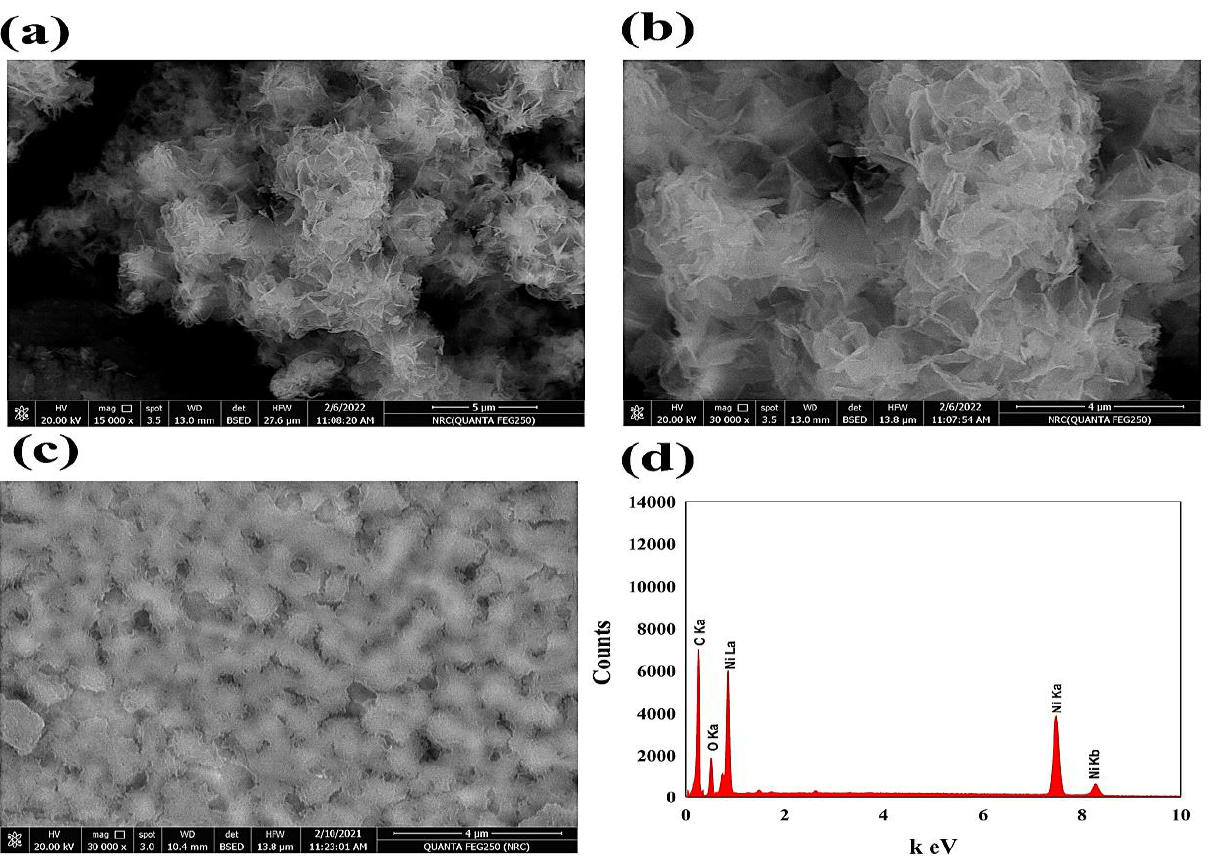
Figure 2. ( a , b ) SEM images of NiOnF at different magnifications, ( c ) PANI, ( d ) EDAX spectrum of NiOnF.